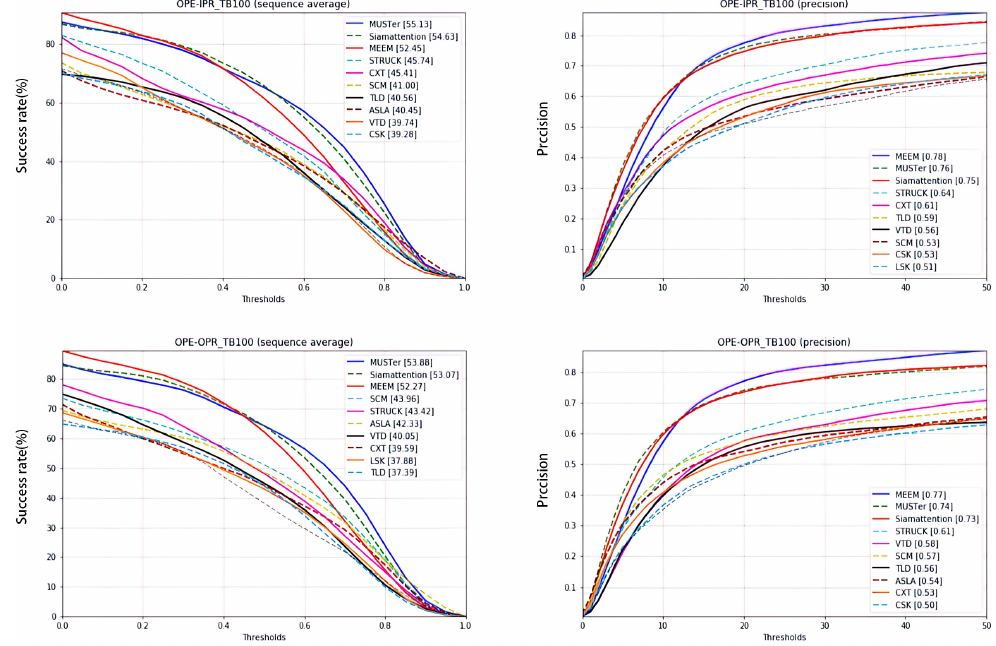
Figure 8. The success plot under IPR and OPR conditions; the proposed tracker is shown by the green dotted lines, ranking second. In the precision plot, it is shown by the red solid line, ranking